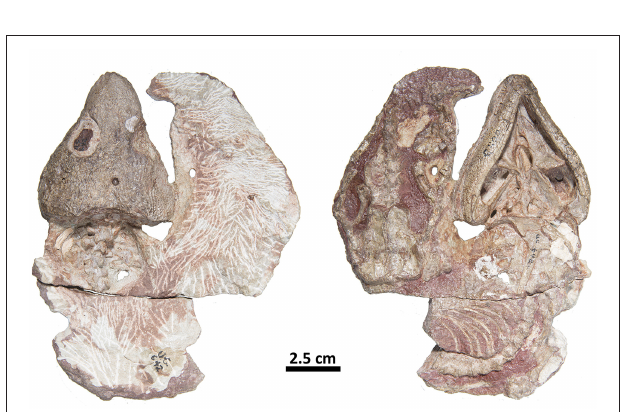
FIGURE 6 | OUSM15102— Captorhinus laticeps in left and right lateral views with an offset close-up view of the marginal dentition in mesial view. Note the peg-like form of the teeth. Unlike the teeth found in Captorhinus kierani , there is no observable descending antero-mesial ridge on any of the teeth. Prominent carinae along the lateral mesiodistal surface also appear to be